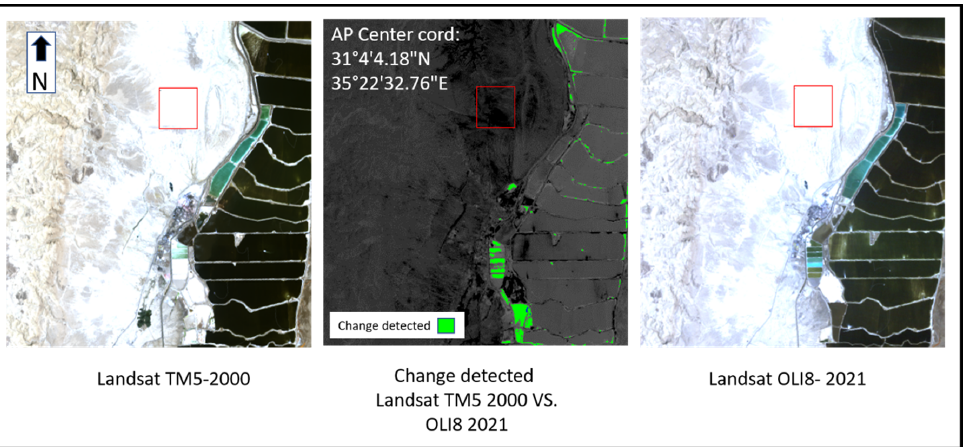
Figure 4. Spatial change detection result for AP, 2000 vs. 2021. Test site is marked in a red box; detected changed pixels are colored in green (center image).